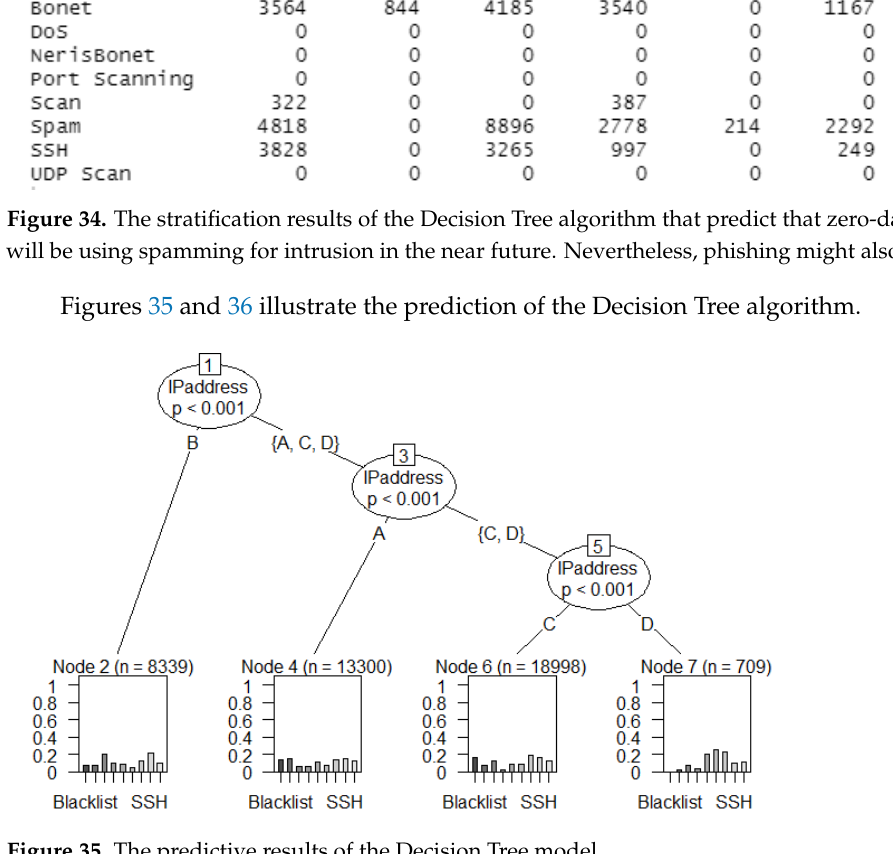
Figure 35. The predictive results of the Decision Tree